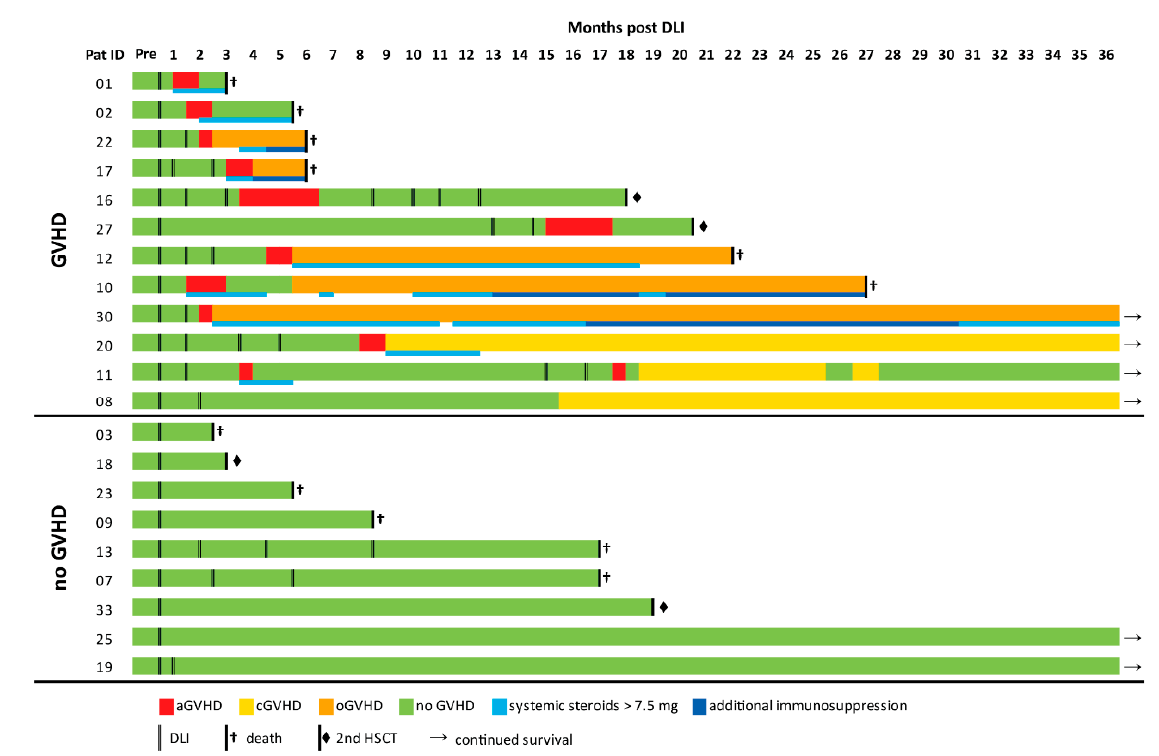
Figure 2. GVHD outcome post DLI. Lines represent individual patients’ GVHD histories during a study follow-up of 36 months; color coding indicates timing and duration of acute GVHD (red), overlap GVHD (orange), chronic GVHD (yellow), noGVHD (green), and periods of treatment with systemic steroids (>7.5 mg; light blue) and additional immunosuppression (dark blue). Application of DLI is marked by double lines. Arrows represent continued survival beyond the study follow-up, and symbols behind bold lines give details on study endpoint ( (cid:7) = second allogeneic hematopoietic stem-cell transplantation; † = death). Table 1. Cohort overview.